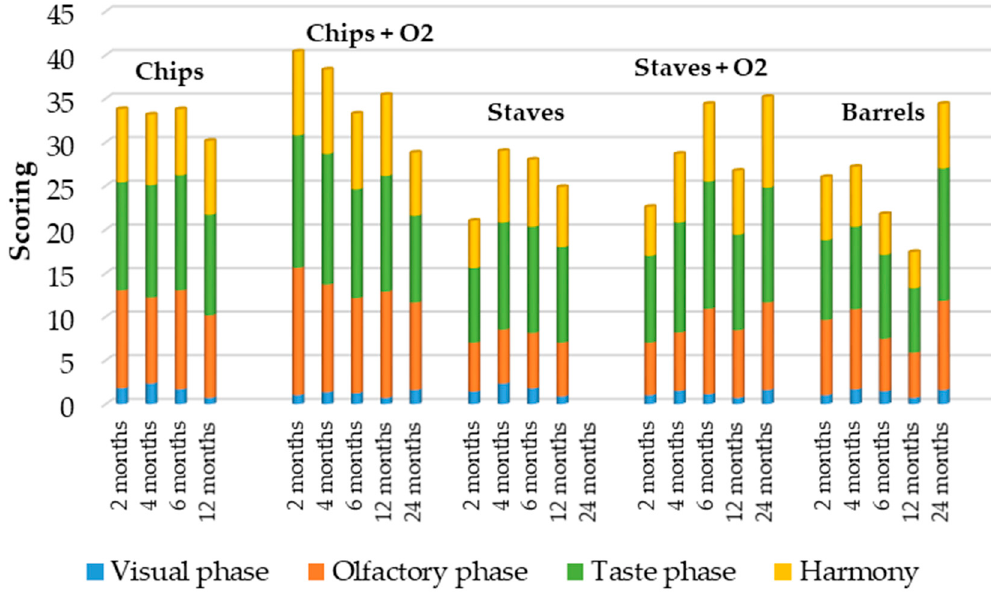
Figure 9. Sensory average valuation of wines over time.